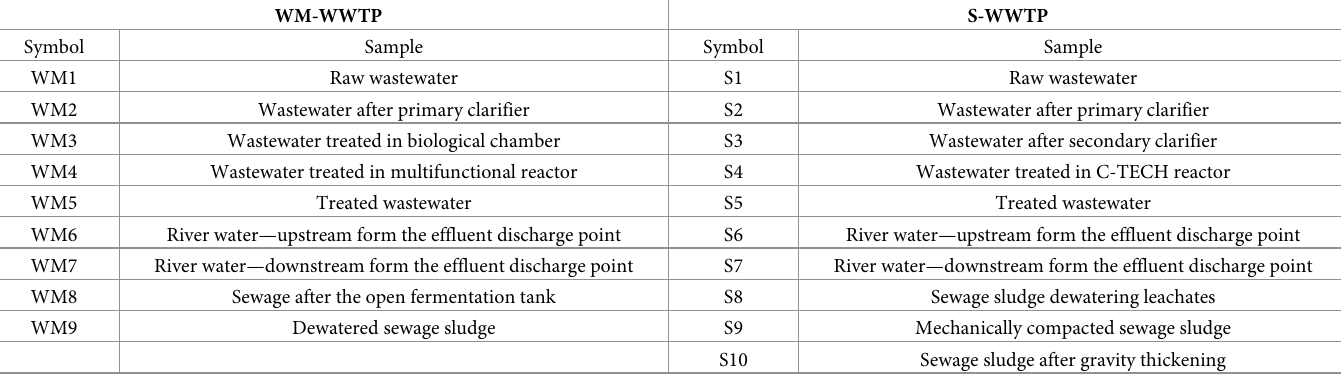
Table 1. Detailed information about samples type collected from wastewater treatment plants.